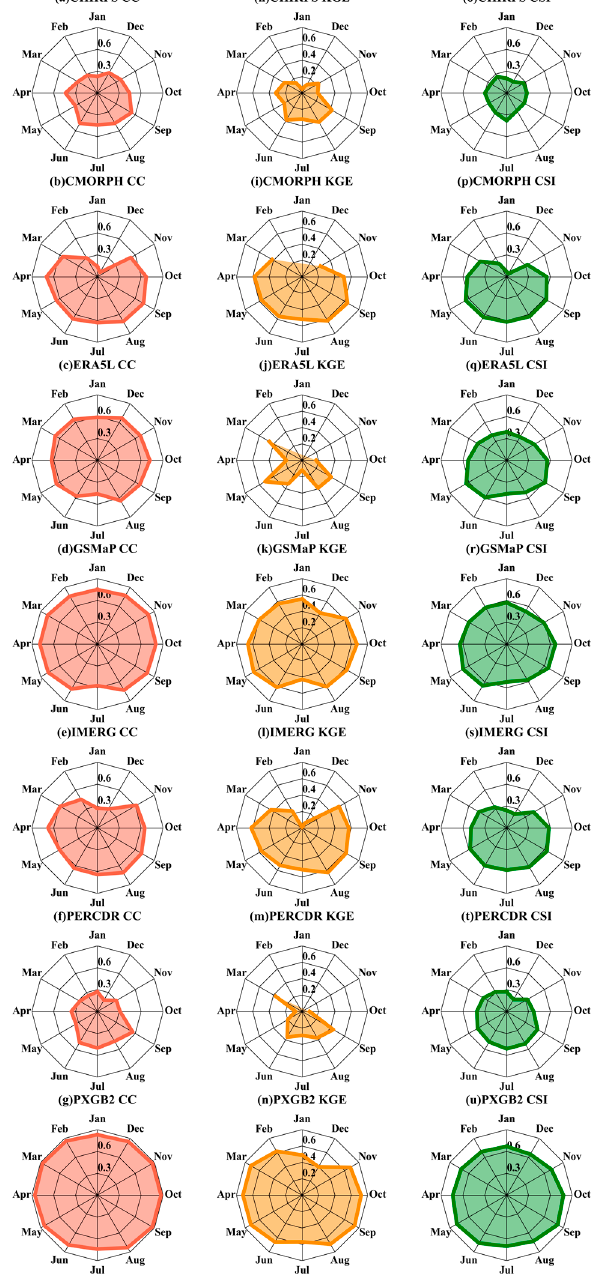
Figure 4. The CC ( a – g ), KGE ( h – n ), and CSI ( o – u ) for each month of MSPs from 2001 to 2006 in JLR basin. The range of KGE is ( − ∞ , 1), and the negative value of KGE is not shown in the figure.